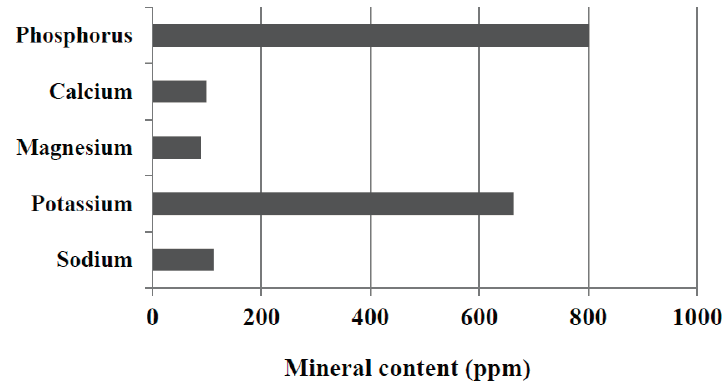
Figure 1. The content of phosphorus, calcium, magnesium, sodium, and potassium of the control potato